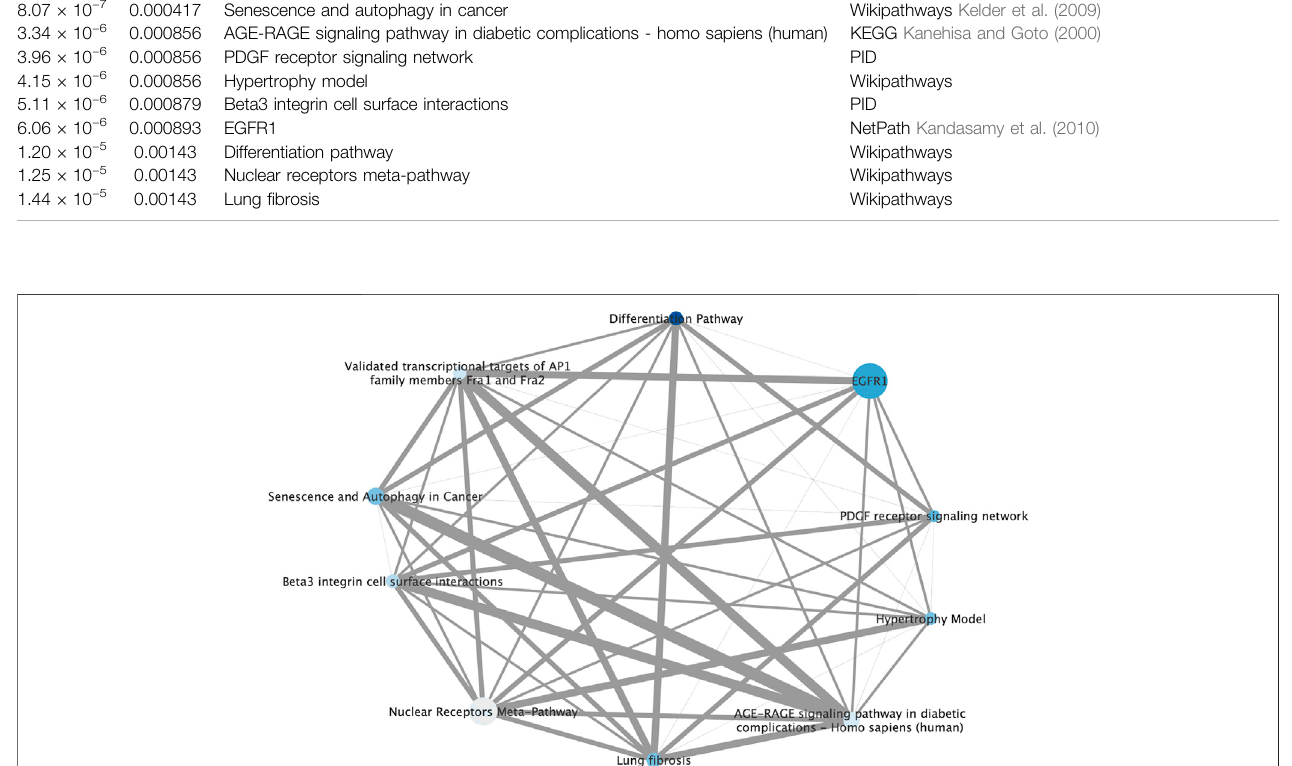
FIGURE 4 | Pathway level interaction network of 10 highly enriched pathways in the ginsenoside Rb2/Rg3 combination-treated cells annotated according to ConsensusPathDB compared to control, providing synergy hypotheses of the compound combination. Node size is based on number of genes represented in each pathway gene set, color is determined by statistical enrichment value (darker blue (cid:2) higher p value) and edge thickness represents the total number of genes shared between each pathway. (Detailed information about each pathway and its p value can be seen in Table 2 .) It can be seen that growth factor receptor-mediated pathways such as EGFR1 and PDGF are major signaling that may contribute promoting effects on endothelial cell proliferation. Also, other pathways which are AP1, autophagy differentiation pathways are also known to be involved in regulating cell growth.